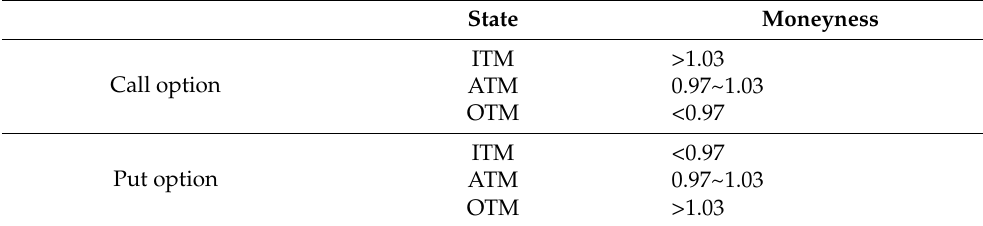
Table 2. Description of